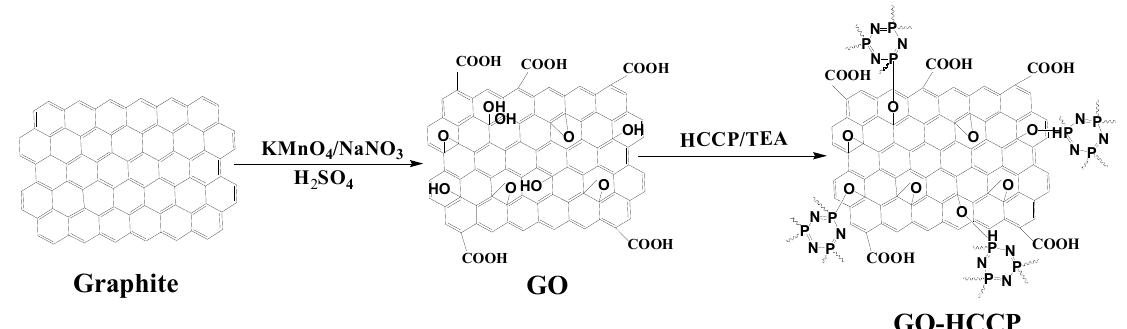
Figure 1. The preparation route of GO-HCCP (graphene oxide-hexachlorocyclotriphosphazene).